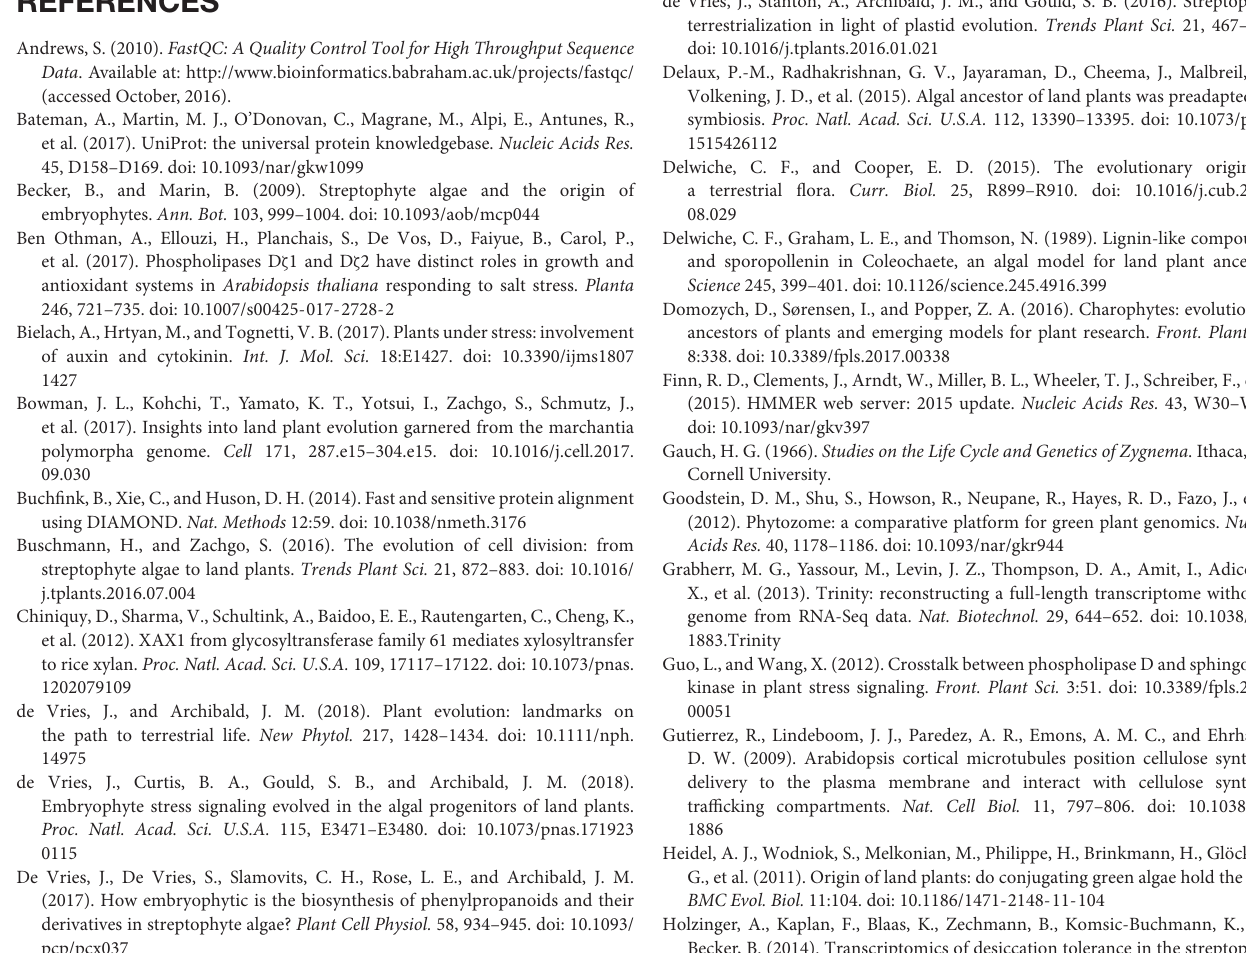
included in the tree leaves. The UTEX 1559 proteins that were selected for qRT-PCR analysis were highlighted with orange background and the proposed gene names ( Table 5 ) were indicated with black lines. FIGURE S3 | The phylogeny of GT47 proteins from selected species of land plants and algae. In total 522 GT47 protein sequences of 14 plant and algal species were used to build this phylogeny (see section “Materials and Methods”). For Arabidopsis proteins, the gene names (adopted from Møller et al., 2017) were included in the tree leaves. Arabidopsis proteins that are known to be xylan biosynthesis-related were indicated in red (AtIRX7, AtIRX10, and AtIRX10-like). FIGURE S4 | The phylogeny of GT61 proteins from selected species of land plants and algae. In total 74 GT61 protein sequences of 14 plant and algal species were used to build this phylogeny (see section “Materials and Methods”). The A and C clades classification was adopted from Chiniquy et al. (2012). The characterized grass XAT and XAX were indicated to be present in the clade C. FIGURE S5 | The phylogeny with land plant CesAs and CGA CesAs (former CslD-like clade). This is the complete version of Figure 5 . TABLE S1 | qRT-PCR primers of the 15 GT candidate genes. DATA SHEET S1 | Significantly enriched GO terms in the eight OGC groups vs. the control (Chl + Cha + Emb). There are 10 sheets, including eight sheets for the eight OGC group, and two additional sheets with selected GO terms from the Cha + Emb group and the Emb group. The selected GO functions are highlighted with different colors and discussed in the